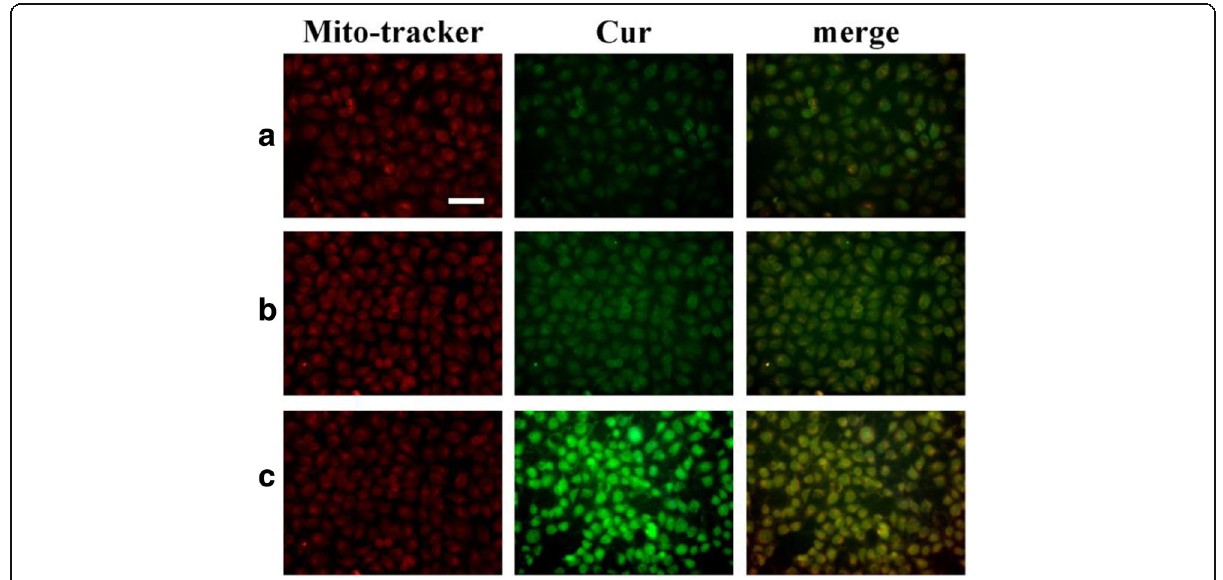
Fig. 8 Mitochondrial localization. Mitochondrial localization was determined by staining with mitochondrial trackers in MCF-7 cells with the treatment of free Cur ( a ), oHA-Cur ( b ), and TPP-oHA-S-S-Cur ( c ); scale bar: 100 μ m